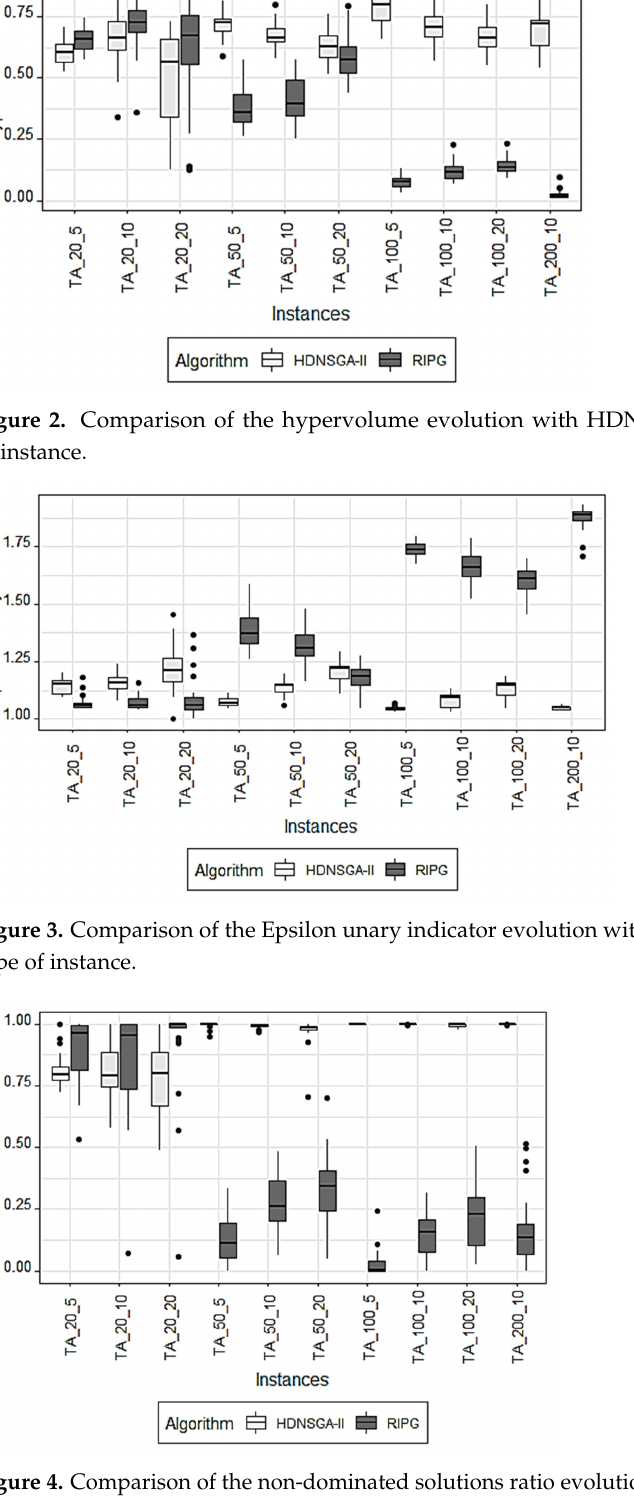
Figure 4. Comparison of the non-dominated solutions ratio evolution with HDNSGA-II and RIPG in each type of instance.